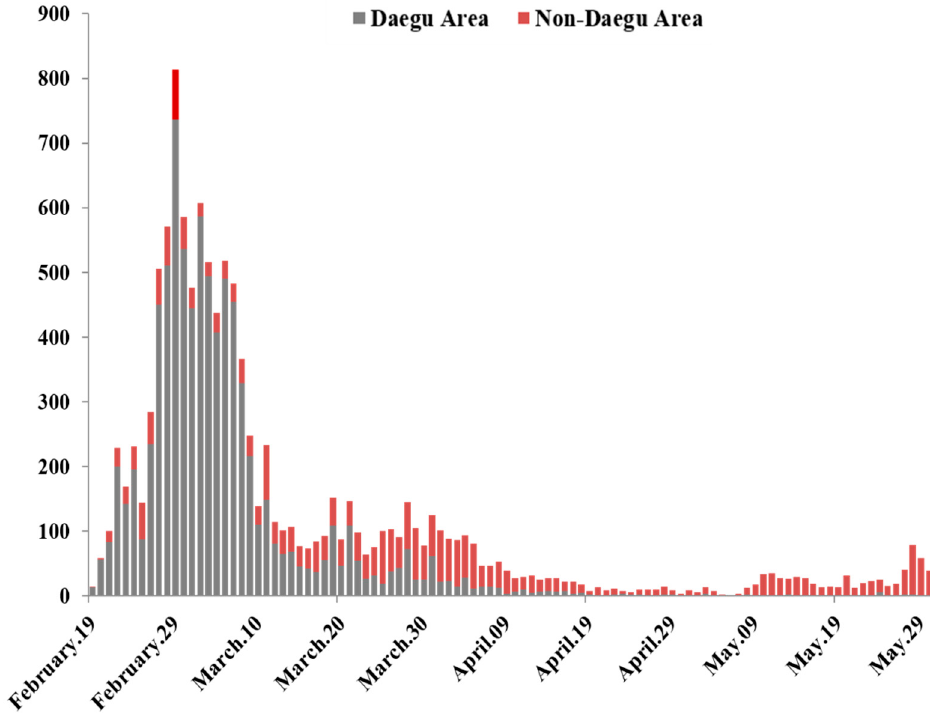
Figure 1. Regional distribution of confirmed COVID-19 cases.